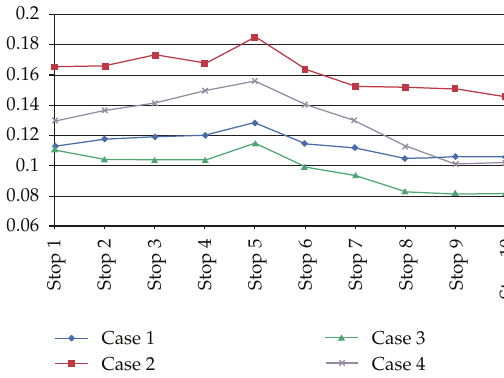
Figure 2: Stop-level changing of coe ffi cient of variance of